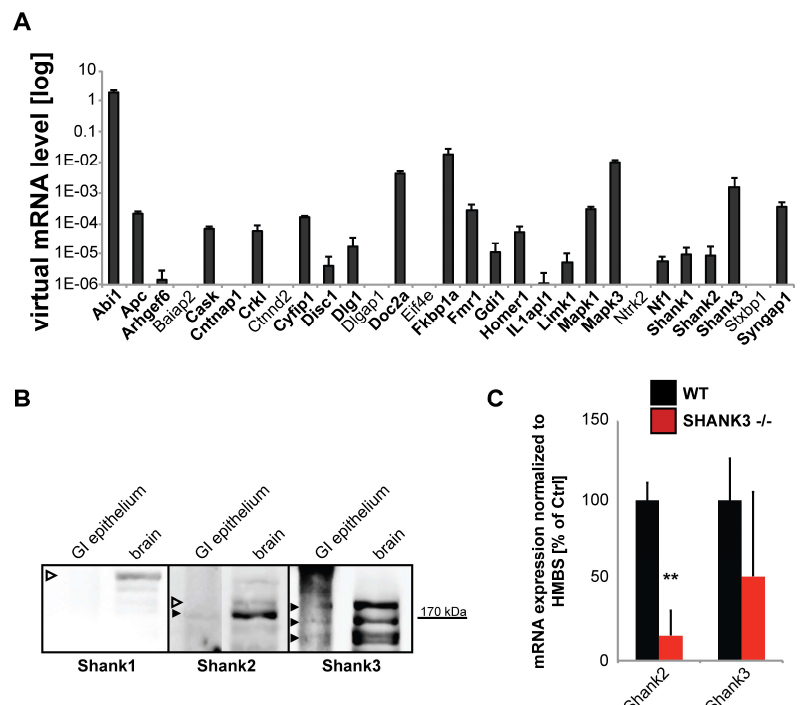
Figure 1. Expression of autism spectrum disorder (ASD)-associated postsynaptic density (PSD) proteins in gut epithelial cells. Several further ASD-associated PSD proteins are expressed in gut epithelial cells. ( A ) Screening of lysate from wild type mice ( n = 5; used in technical triplicates) from isolated gut epithelium for the expression of “synaptic” ASD-associated genes using qRT-PCR. The genes were selected based on their occurrence at excitatory postsynapses and a reported association with ASD. On mRNA level, expression of all SH3 and multiple ankyrin repeat domains ( Shank) family members was detected, as well as the expression of several direct interacting proteins such as Abi1 (Abelson interactor 1), and Homer1 (Homer protein homolog 1). Furthermore, the expression of Apc (Adenomatous-polyposis-coli), Arhgef6 (Rac / Cdc42 Guanine Nucleotide Exchange Factor (GEF) 6, Alpha-PIX), Cask (Calcium / Calmodulin-Dependent Serine Protein Kinase), Cntnap1 (Contactin Associated Protein 1), Crkl (V-Crk Avian Sarcoma Virus CT10 Oncogene Homolog-Like), Cyfip1 (Cytoplasmic FMR1 Interacting Protein 1), Disc1 (Disrupted In Schizophrenia 1), Dlg1 (Discs, Large Homolog 1), Doc2a (Double C2-Like Domains, Alpha), Fkbp1a (FK506 Binding Protein 1A), Fmr1 (Fragile X Mental Retardation 1), Gdi1 (GDP Dissociation Inhibitor 1), Il1apl1 , Limk1 (LIM Domain Kinase 1), Mapk1 and Mapk3 (Mitogen-Activated Protein Kinase 1 and 3), Nf1 (Neurofibromin 1), and Syngap1 (Synaptic Ras GTPase Activating Protein 1) was detected. ( B ) Western Blot analysis for the expression of SHANK family members SHANK1, SHANK2, and SHANK3 using GI epithelium and brain tissue from wild-type mice. Only expression of SHANK2 and SHANK3 was detected on protein level in GI epithelium (full arrows). ( C ) Expression-analysis Shank2 and Shank3 in wildtype and Shank3 αβ KO mice. Significantly lower expression of Shank2 was found in Shank3 αβ KO mice ( t -test, 3 technical replicates from 3 animals per group; Shank2 p = 0.0067 ( n = 3); ** p <